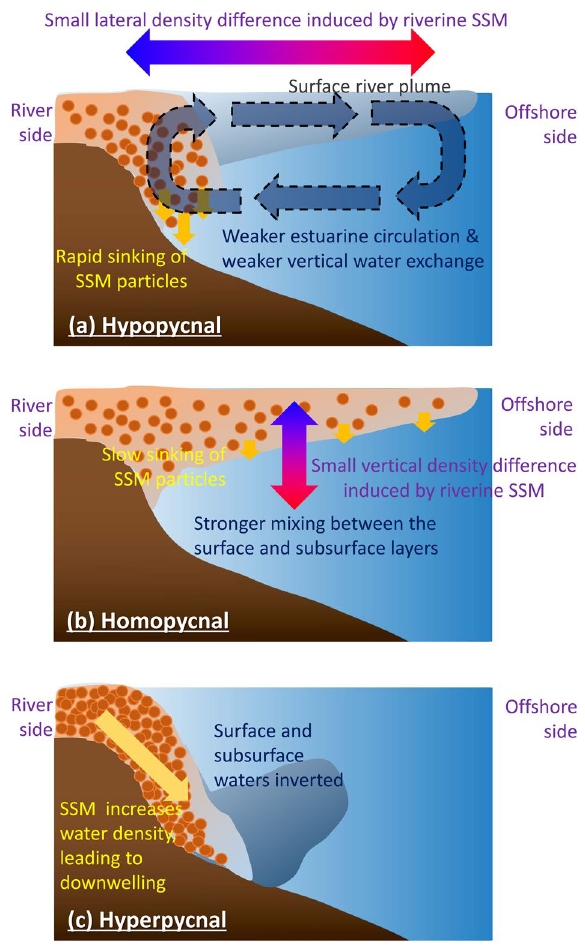
Figure 1. Schematic representation of processes of suspended sediment matter (SSM) and physical field interaction in ( a ) hypopycnal plume, ( b ) homopycnal plume, and ( c ) hyperpycnal plume cases. Figures were created using Adobe Illustrator CC 2018 and Microsoft Powerpoint